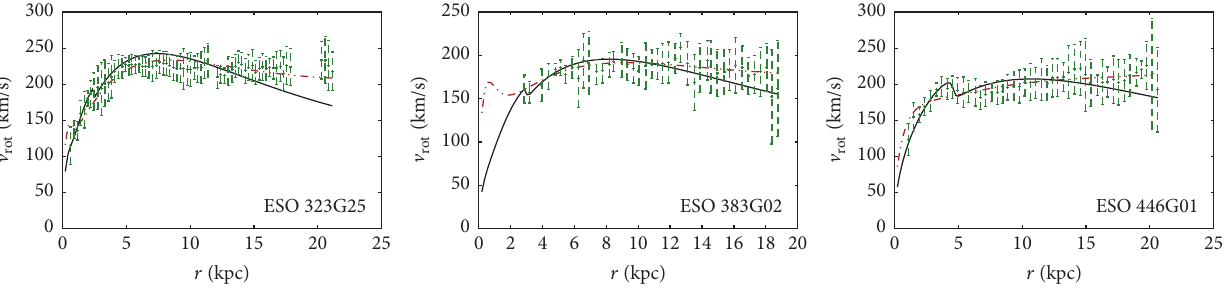
Figure 2: Best fit curves for the HSB II. galaxy sample. The solid black lines hold for the baryonic matter + BEC model, while the dashed red lines hold for the baryonic matter + NFW model. The BEC model does not describe well the extended flat